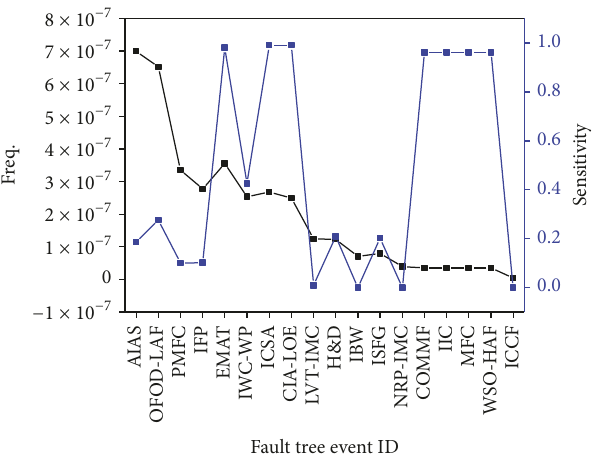
Figure 15: Sensitivity versus frequency for CCF-accidents data.